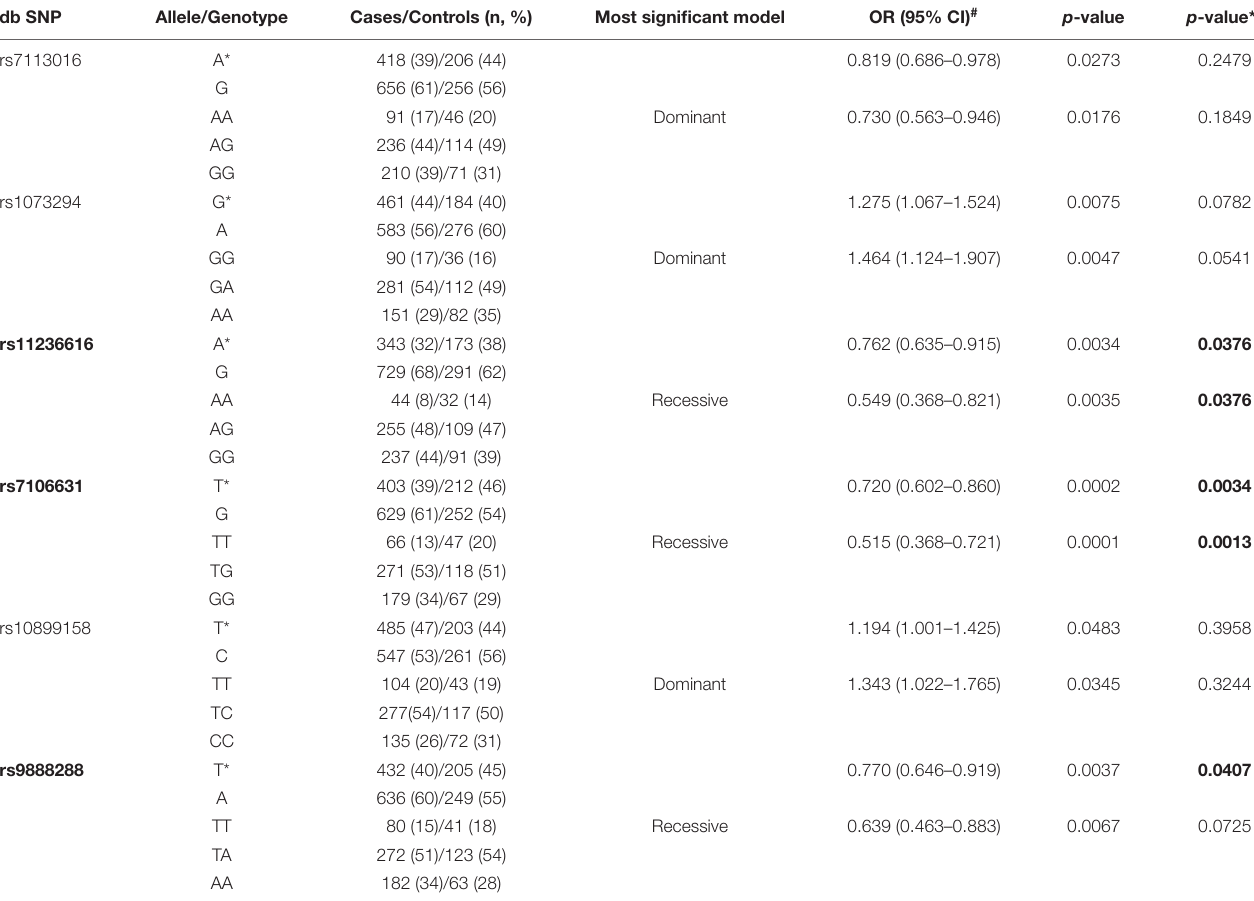
TABLE 2 | Significant SNPs in SHANK2 (ADHD/ASD/ADHD + ASD vs. control/pseudo-control). db SNP Allele/Genotype